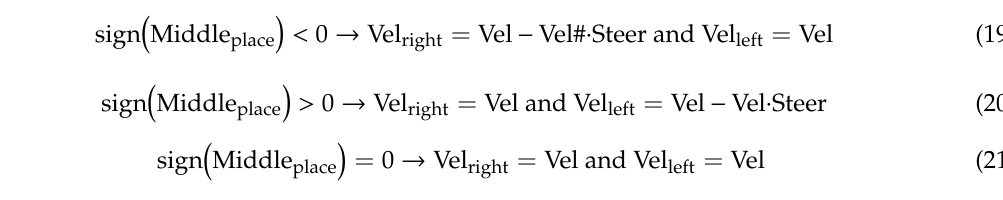
Figure 9. Sketch of the indoor scenario. The results are determined by comparing the speed command for each motor and controlling the execution time of the neural network. Moreover, some pictures are captured to understand the calculated path. Figure 10 represents the AMR trajectory during execution, which shows that the robot can move freely while avoiding the obstacles and walls.